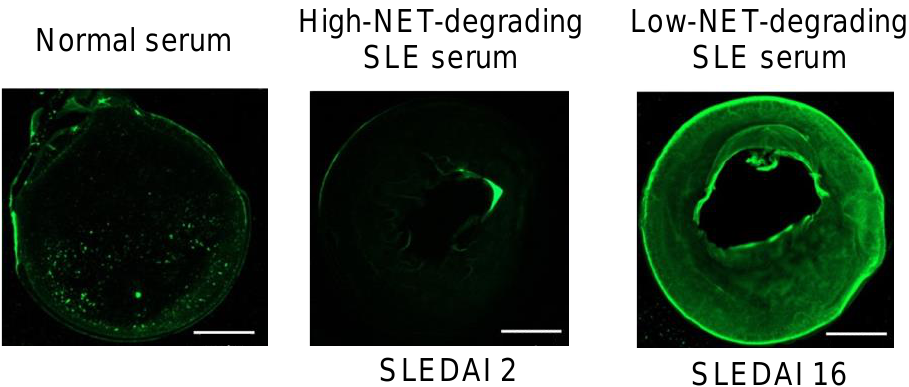
Figure 6. DHM degradation by normal serum and systemic lupus erythematosus (SLE) serum previously determined to have high- or low-NET-degrading capabilities. The high-NET-degrading SLE serum was from a patient with low disease activity (SLEDAI 2) while the low-NET-degrading SLE serum was from a patient with high disease activity (SLEDAI 16). DHMs pre-stained with 1 µ M SYTOX Green were incubated with serum for 12 h. Note significant residual DHMs remaining after treatment with SLE serum from patient with high SLEDAI score. The images are representative of n = 3. The scale bar is 0.83 μ m.